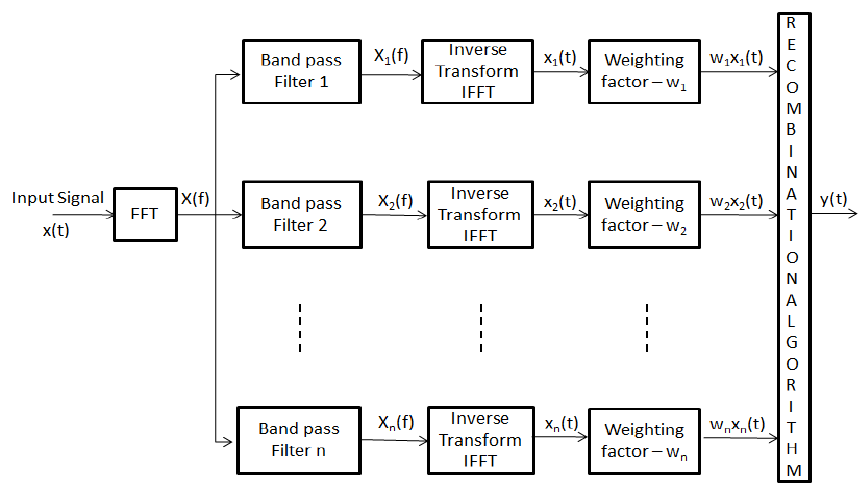
Figure 2. Split-spectrum processing (SSP) block diagram.